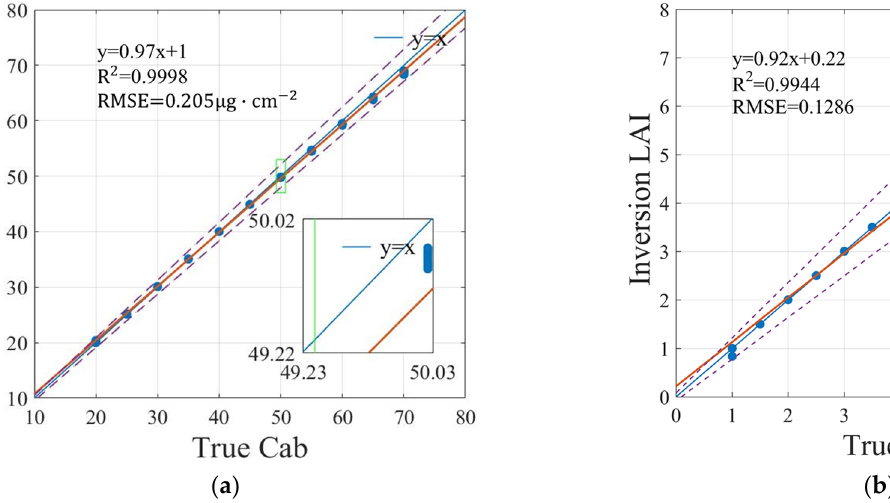
Figure 10. Validation of the Cab and LAI with the OE-iteration method: ( a ) validation of the Cab with the OE-iteration method against the true value under different AODs and ( b ) validation of the LAI with the OE-iteration method against the true value under different AODs. The blue solid line, dashed line, and orange solid line are the 1:1 line, error line, and fit line, respectively. The error lines of ( a , b ) are E = x ± 0.04 x ± 0.08.and E = x ± 0.14 x ± 0.08. The statistics of the linear fitting result, including slope, intercept, R 2 , and RMSE, are listed in the upper left corner of each scatter plot.